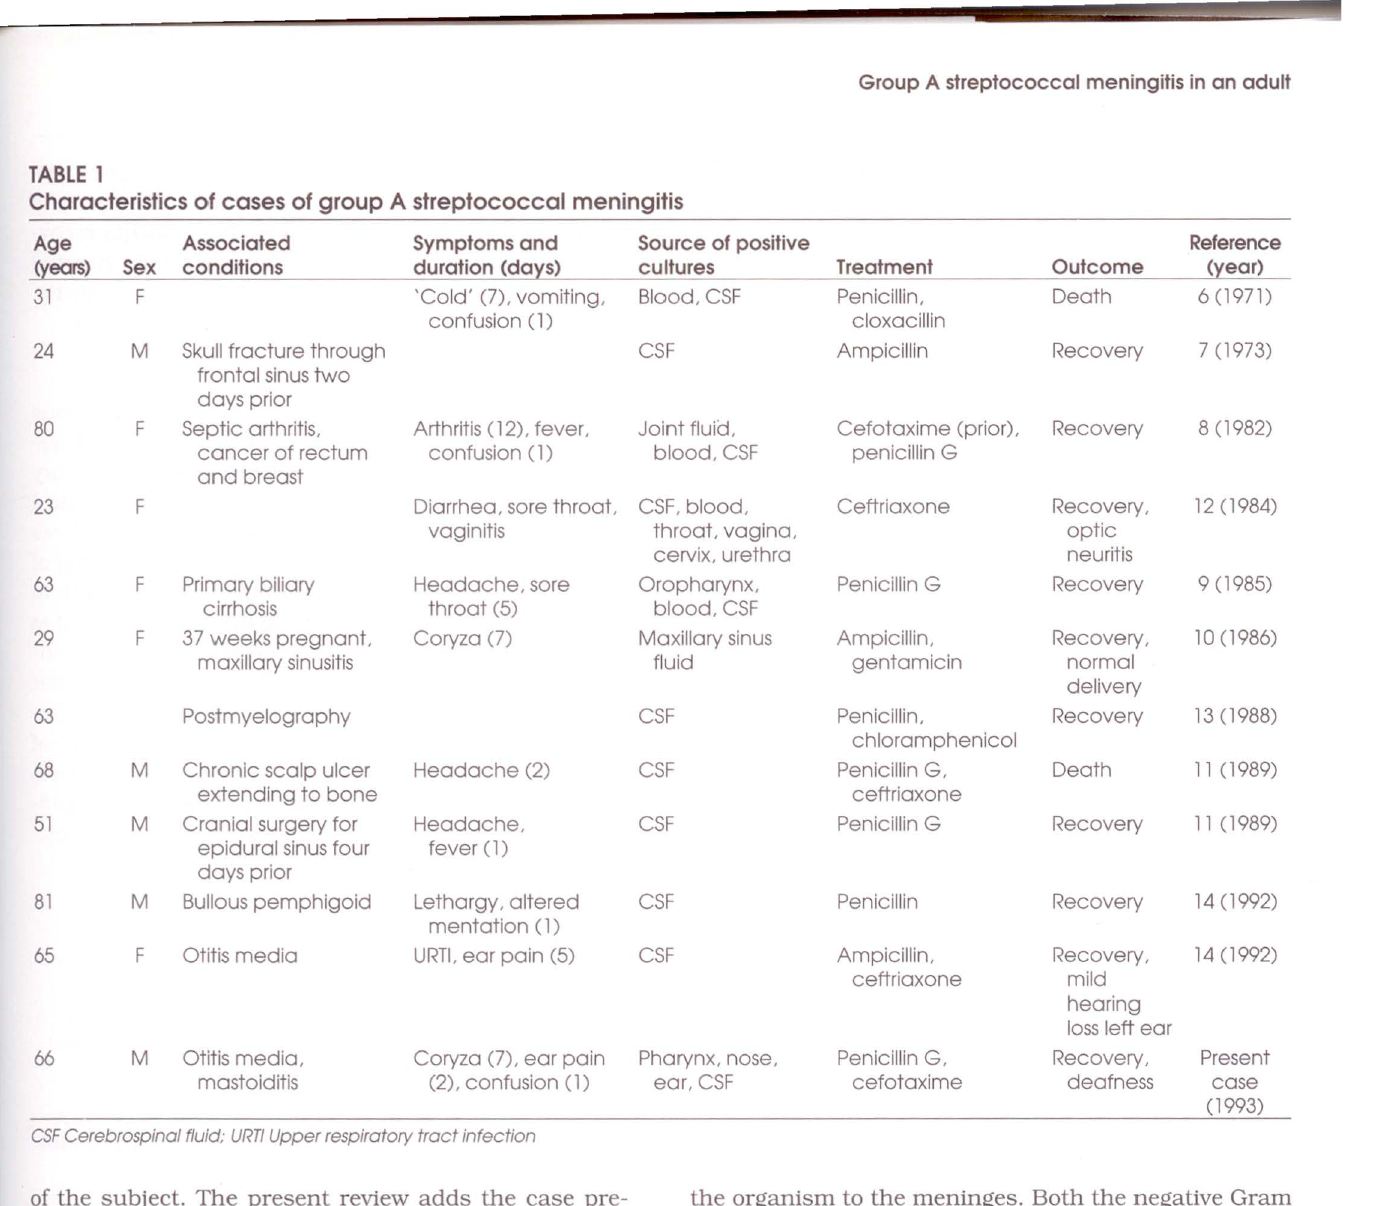
Characteristics of cases of group A streptococcal